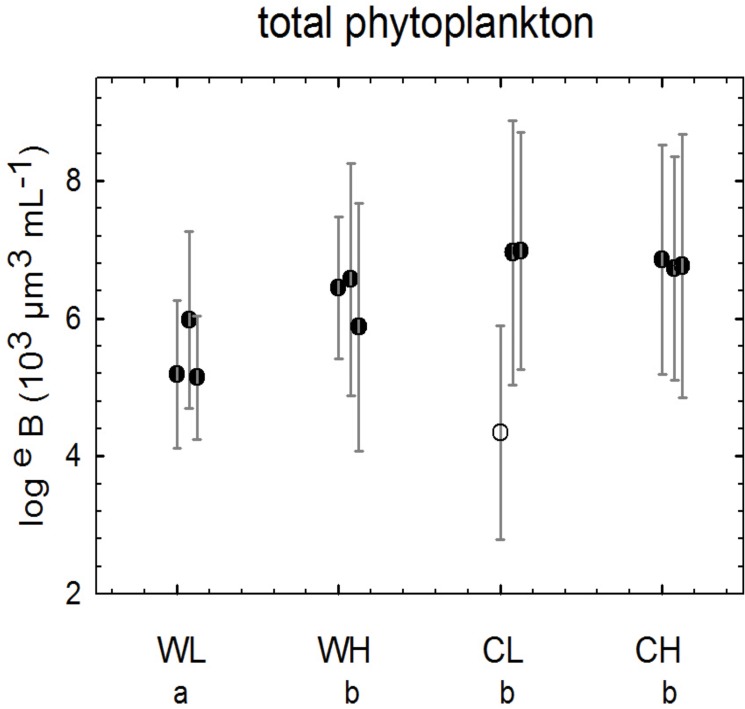
Means of total phytoplankton biomass.Means over entire experiment calculated after loge-transformation and standard deviations (vertical lines). Mesocosm is 9 shown by an open symbol. Treatment codes: WL: warm, low CO2, WH: warm, high CO2, CL: cold, low CO2, CH: cold, high CO2; codes for homogenous groups according to Tukey’s HSD: a, b.